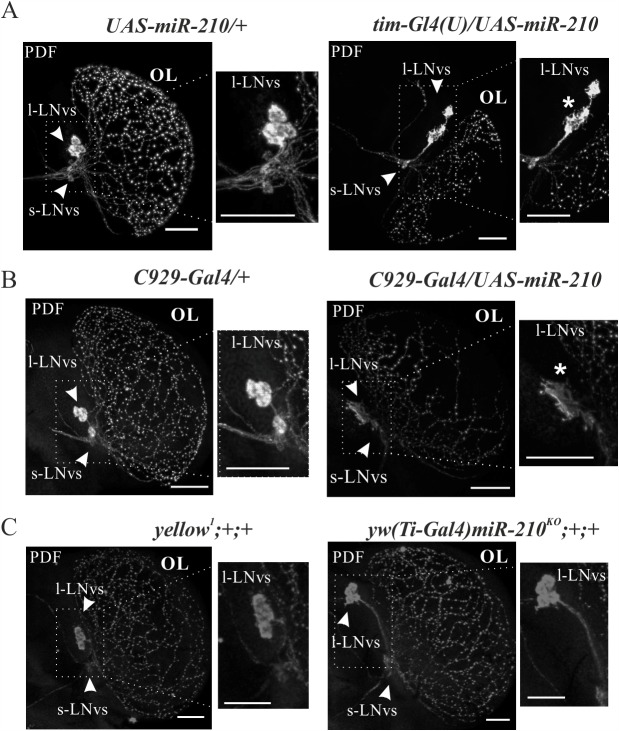
PDF staining of l-LNvs.Whole brains were collected at ZT0 and PDF was detected. Confocal stack images representing l-LNvs arborisations and morphology. (A) Flies over-expressing miR-210 in all clock cells (tim-Gl4(U)/UAS-miR-210) showed aberrant PDF arborisations in the optic lobes compared to controls (UAS-miR-210/+). Cell bodies of the l-LNvs exhibited a star shaped phenotype (marked with an asterisk). (B) Targeted miR-210 over-expression in l-LNvs clock neurons (C929-Gal4/UAS-miR-210) and controls (C929-Gal4/+). The l-LNvs appeared to have the same defects in their projections to the optic lobes and in their cell bodies, as in tim-Gl4(U)/UAS-miR-210 flies (marked with an asterisk). (C) No l-LNvs arborisation defects were detected in yw(Ti-Gal4)miR-210KO;+/+ flies compared to controls (yellow1;+/+). (OL: Optic Lobe; scale bar: 25 μm).